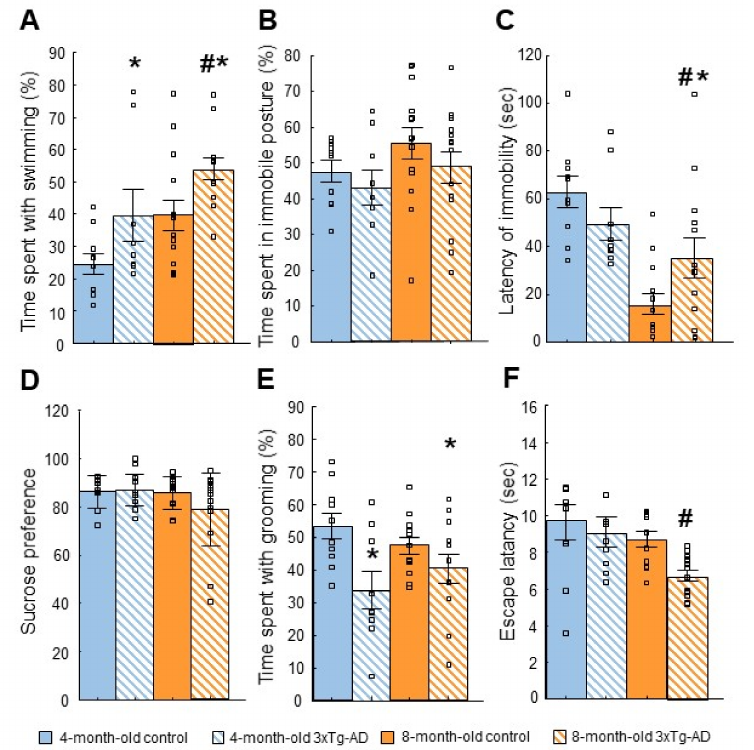
Figure 3. Depressive-like behavior. ( A ): Forced swim (FST) test. There was a significant difference in the time spent swimming regarding the effect of genotype (* p = 0.01) and age (# p = 0.00). ( B , C ): Tail suspension (TST) test. ( B ): There was no significant difference between the groups in the time spent in immobile posture ( p > 0.05). ( C ): In the case of the latency of immobility, there was a significant difference between genotypes (age*genotype: *# p = 0.02). ( D ): Sucrose preference test (SPT). Both genotypes preferred sucrose solution over water in both age groups, there was no significant difference between groups. The sucrose preference value differed from random 50% in each case ( p = 0.00 in each single-sample t -test against 50). ( E ): Splash test. There was a significant difference between the genotypes in the time spent grooming in both age groups (* p = 0.00) with significantly less time spent grooming in the 3xTg-AD groups. ( F ): Learned helplessness (LH). Escape latency was lower in 3xTg-AD than in the control mice ( p = 0.05). There was a surprising decrease in escape latency with advancing age: it was significantly lower in 8-month-old animals compared with 4-month-old ones (age: # p =